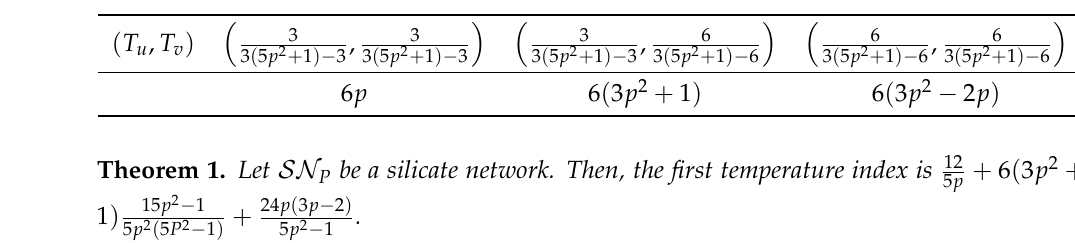
Table 1. Atom bond partition of SN P based on the valency of each atom of SiO 4